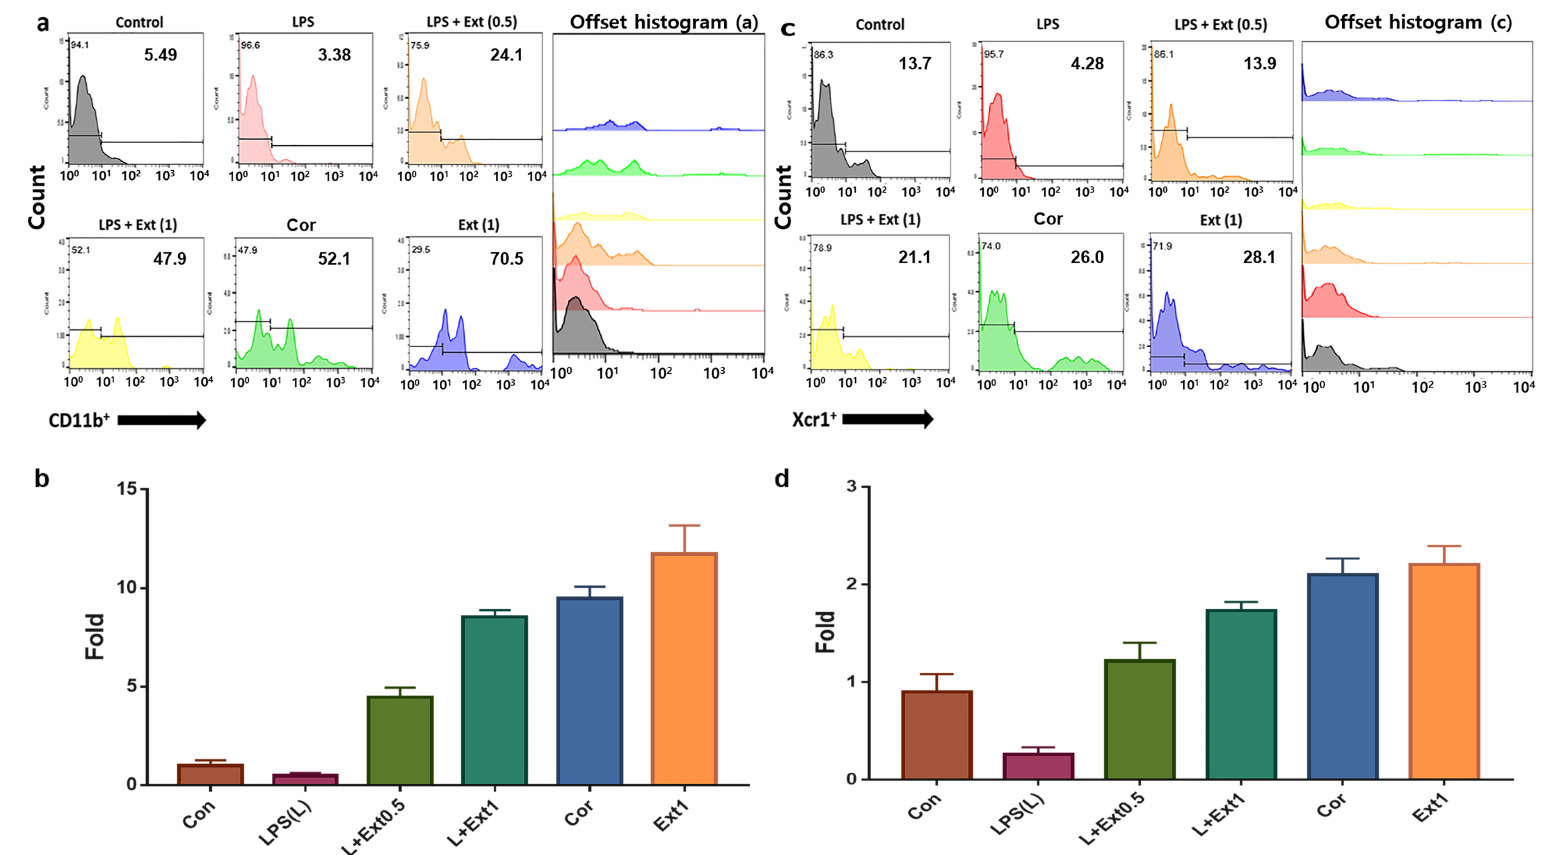
Figure 6. Dendritic differentiation by activated macrophages in the various conditioned media. Differentiated dendritic cells were counted by flow cytometry and were analyzed using the FlowJo software 10.6.1. Panels ( a , b ) show the density of CD11b + cells under various conditions as follows: LPS only, extract 0.5 µ g/mL and 1 µ g/mL (Ext 0.5, 1), followed by LPS treatment, cordycepin, and extract. Panels ( c , d ) show the density of Xcr1 + cells under the same conditions. LPS; lipopolysaccharide, Ext; extract, Cor; cordycepin ( p <